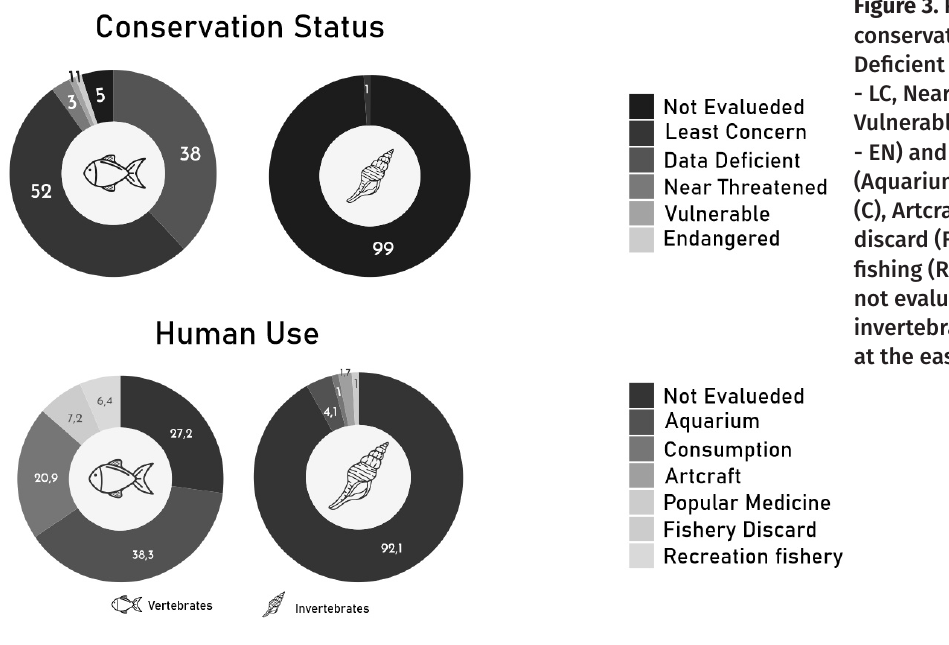
Figure 3. Percentage of conservation categories